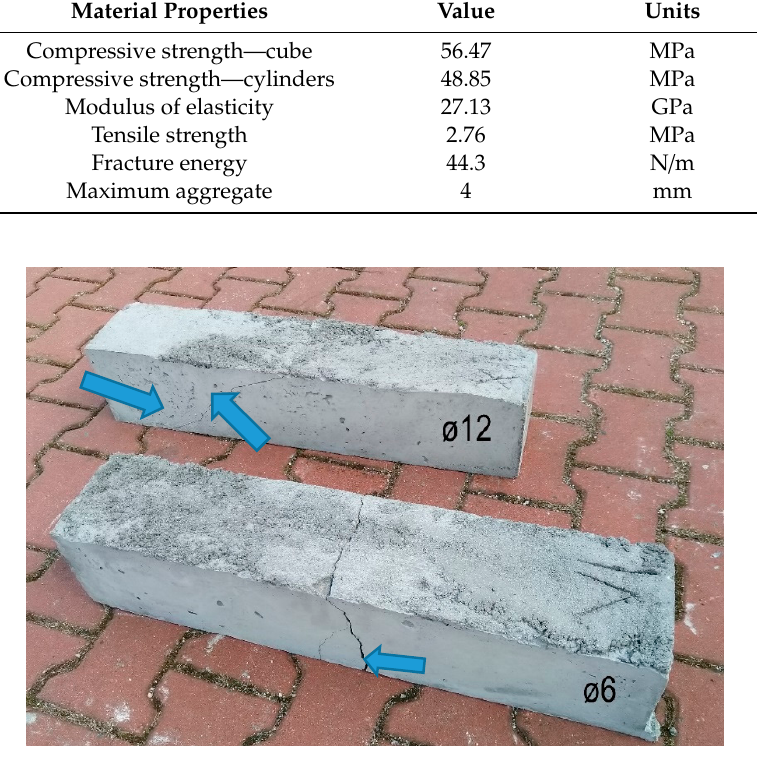
Figure 10. Small RC beams without transverse reinforcement—three-point bending test, with a span of 600 mm. Table 9. Load capacity [kN] of small reinforced concrete beam without transverse reinforcement (diameter 12 mm).